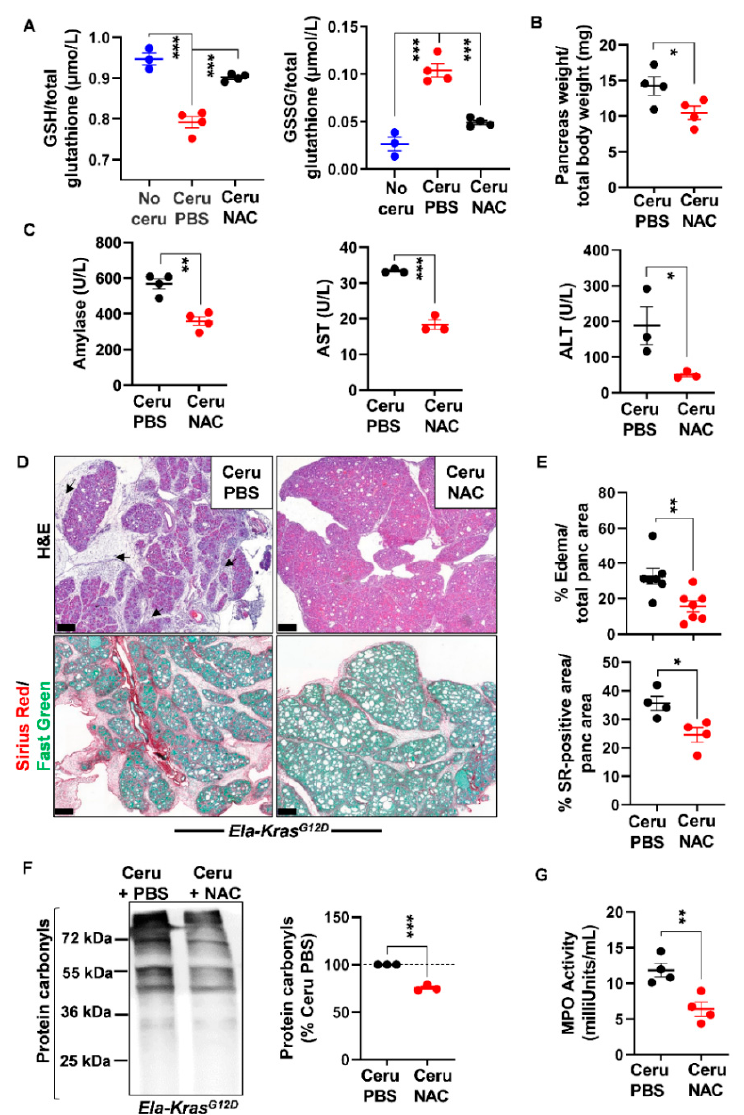
Figure 5. N-acetylcysteine treatment improves acute pancreatitis hallmarks in Ela-Kras G12D mice. ( A ) Reduced glutathione (GSH) and glutathione disulfide (GSSG) measurements in pancreas lysates of Ela-Kras G12D mice treated with cerulein and PBS for 5 days (Ceru PBS; n = 4), cerulein and NAC for 5 days (Ceru NAC; n = 4) or untreated (No ceru; n = 3). ( B ) Pancreas weight normalized to total body weight in Ela-Kras G12D mice treated with cerulein and PBS for 5 days (Ceru PBS; n = 4) or cerulein and NAC for 5 days (Ceru NAC; n = 4). ( C ) Measurement of plasma amylase , aspartate transaminase (AST) and alanine transaminase (ALT) levels in Ela-Kras G12D mice treated with cerulein and PBS for 5 days (Ceru PBS; n = 3–4) or cerulein and NAC for 5 days (Ceru NAC; n = 3–4). ( D ) Hematoxylin and eosin (H&E) staining and Sirius Red (SR) staining on the pancreata of Ela-Kras G12D mice treated with cerulein and PBS for 5 days (Ceru PBS; n = 4–7) or cerulein and NAC for 5 days (Ceru NAC; n = 4–7). Bars: 200 µm. Black arrows show edematous area. ( E ) Whole-tissue quantifications for edema- and SR-positive areas from panel D . ( F ) Western blot for the oxidative damage marker, protein carbonyls, on pancreas lysates of Ela-Kras G12D mice treated with cerulein and PBS for 5 days (Ceru PBS; n = 3) or cerulein and NAC for 5 days (Ceru NAC; n = 3). ( G ) Myeloperoxidase (MPO) activity on pancreas lysates of Ela-Kras G12D mice treated with cerulein and PBS for 5 days (Ceru PBS; n = 4) or cerulein and NAC for 5 days (Ceru NAC; n = 4). Data are mean ± SEM. Statistical signifi- cance for Panel A was tested by one-way ANOVA test and further interactions were analyzed by post hoc test (*** p < 0.001). Statistical significance for panels B – G was tested by Student’s t -test (* p